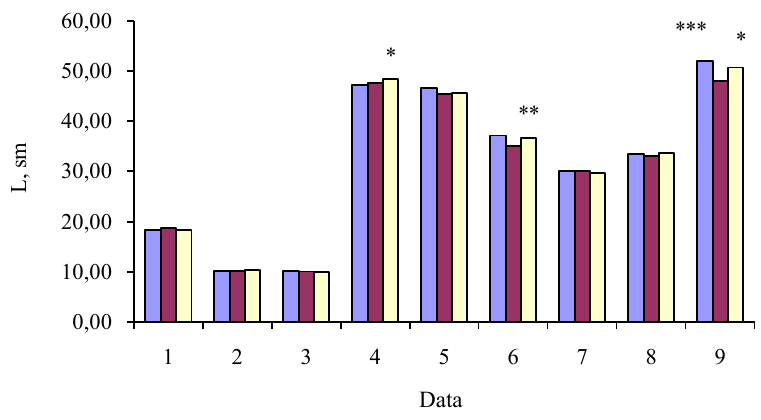
Fig.3. Anthropometrical indicators of elite sportsmen, who specialize in speed climbing (n=10), complex climbing (n=10) and mountaineering